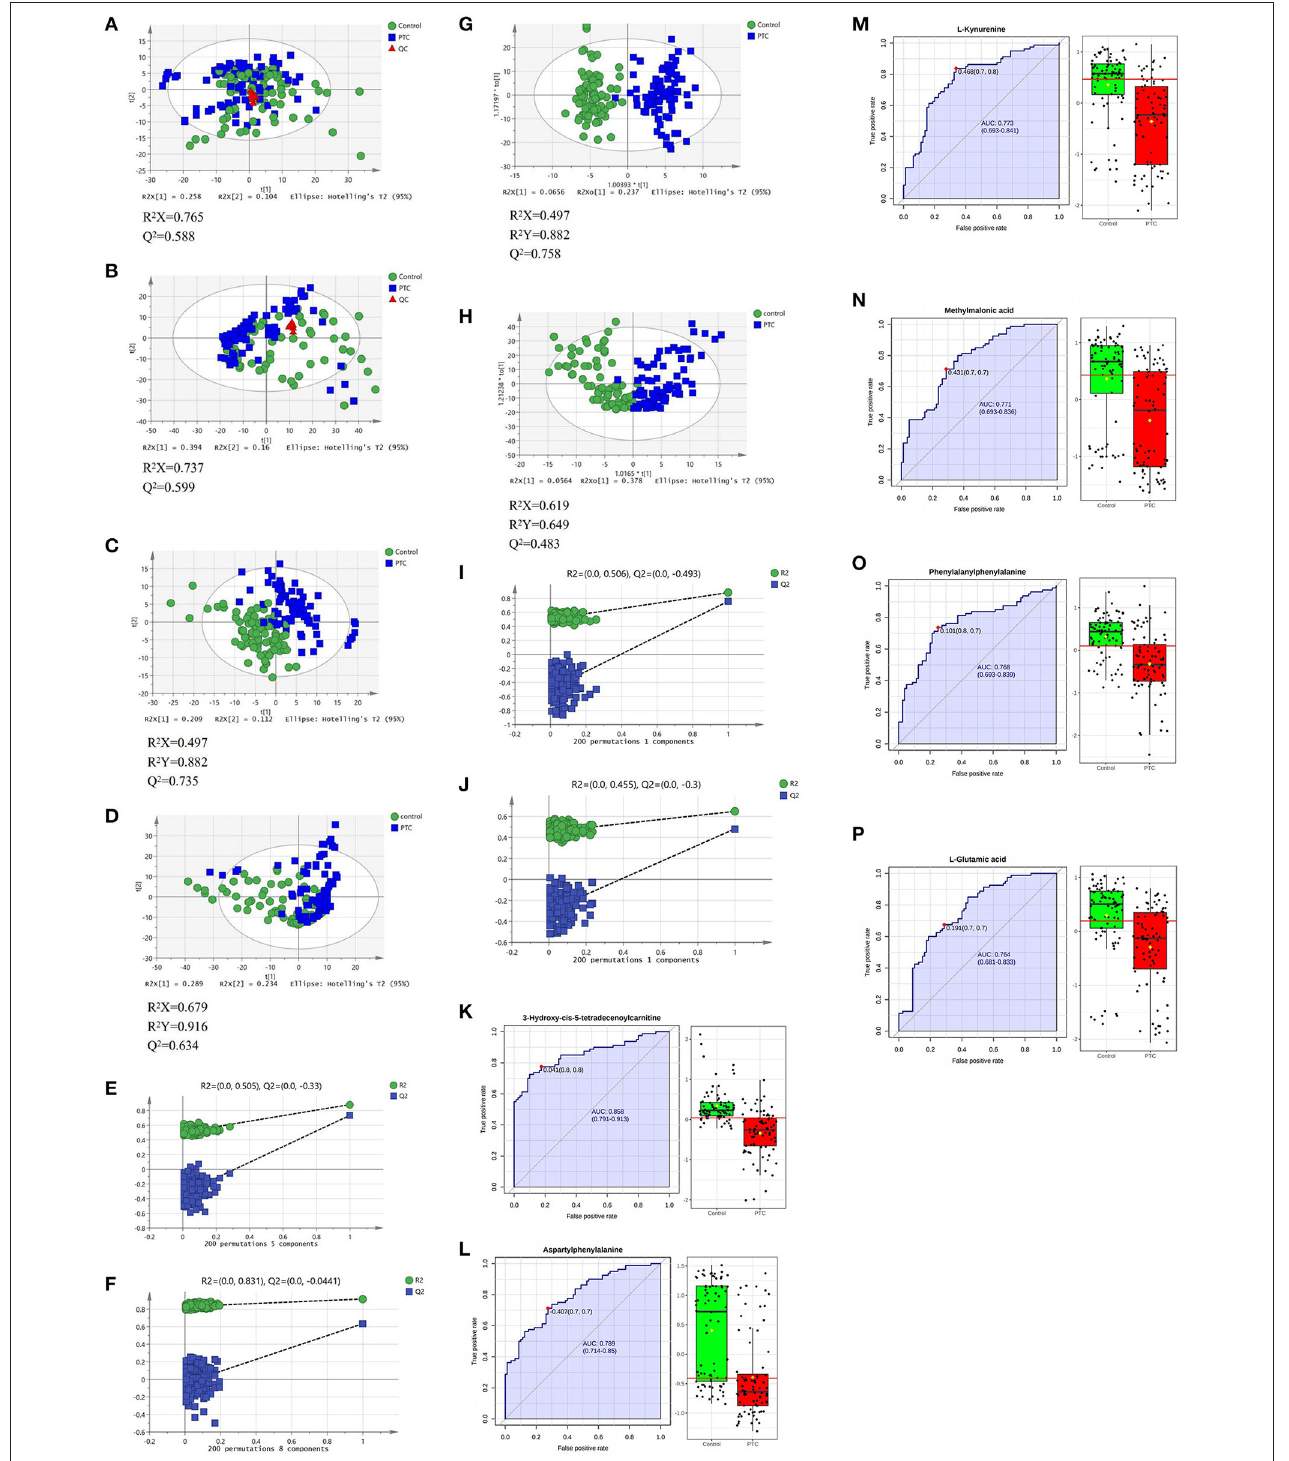
FIGURE 2 | PCA (A,B) , PLS-DA (C,D) , and OPLS-DA (G,H) analysis score scatter plots illustrating that the metabolic profiles of PTC are distinct from those of healthy subjects. PLS-DA and OPLS-DA analysis score scatter plots for metabolic profiles of healthy subjects (green dots) and PTC patients (blue squares) showing clear discrimination between the two groups. (E,F,I,J) Permutation test was used to assess the reliability of the models. ROC curve analyses of the ability of six metabolites to predict PTC patients and healthy subject (K–P) . PCA, principal component analysis; PLS-DA, partial least squares discrimination analysis; OPLS-DA, orthogonal partial least squares-discriminant analysis; QC, Quality Control; PTC, papillary thyroid carcinoma; Control, healthy subject. ROC, receiver operating characteristic.